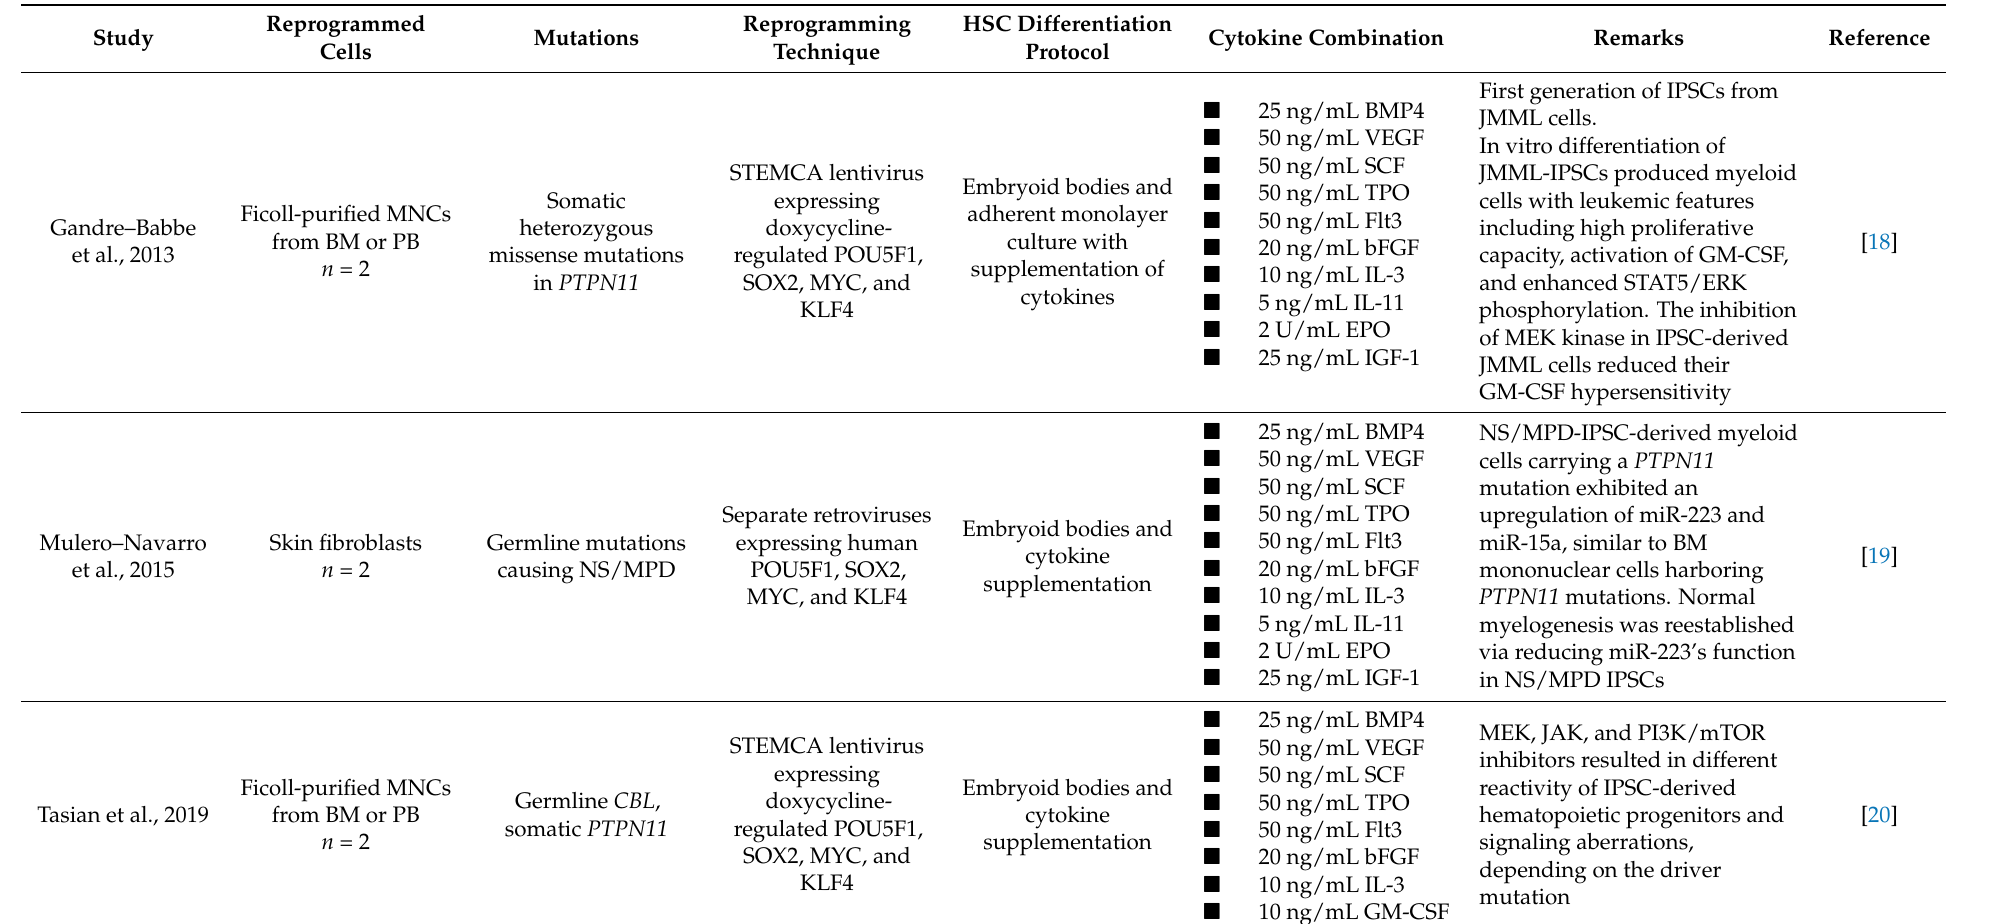
Table 1. Summary of the literature on JMML-derived IPSC studies. Abbreviations: HSC, hematopoietic stem cell; MNC, mononuclear cell; BM, bone marrow; PB, peripheral blood; IPSC, induced pluripotent stem cell; JMML, juvenile myelomonocytic leukemia; GM-CSF, granulocyte-macrophage colony-stimulating factor; NS, Noonan syndrome; MPD, myeloproliferative